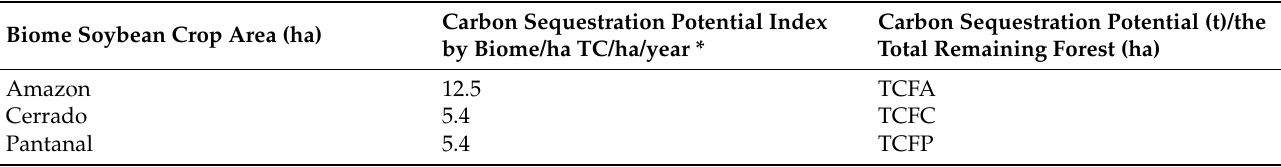
Table 2. Calculations based on remaining forests according to the